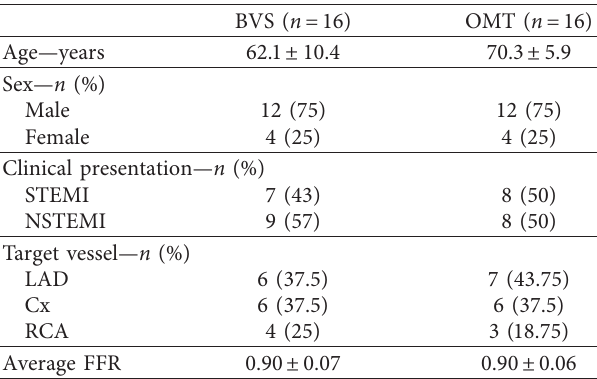
Figure 2: OCT with angiography coregistration of a patient randomised to BVS placement. (a) Angiogram shows an intermediate stenosis in the proximal circumflex coronary artery (white marker). (b) OCTof the stenosis reveals a vulnerable plaque (lipid arc > 90 ° with a cap of 60 μ m). (c) Angiogram shows the same lesions as in A (white marker) after BVS placement. (d). OCTshows BVS placement over vulnerable plaque with good stent Table 2: Baseline characteristics.